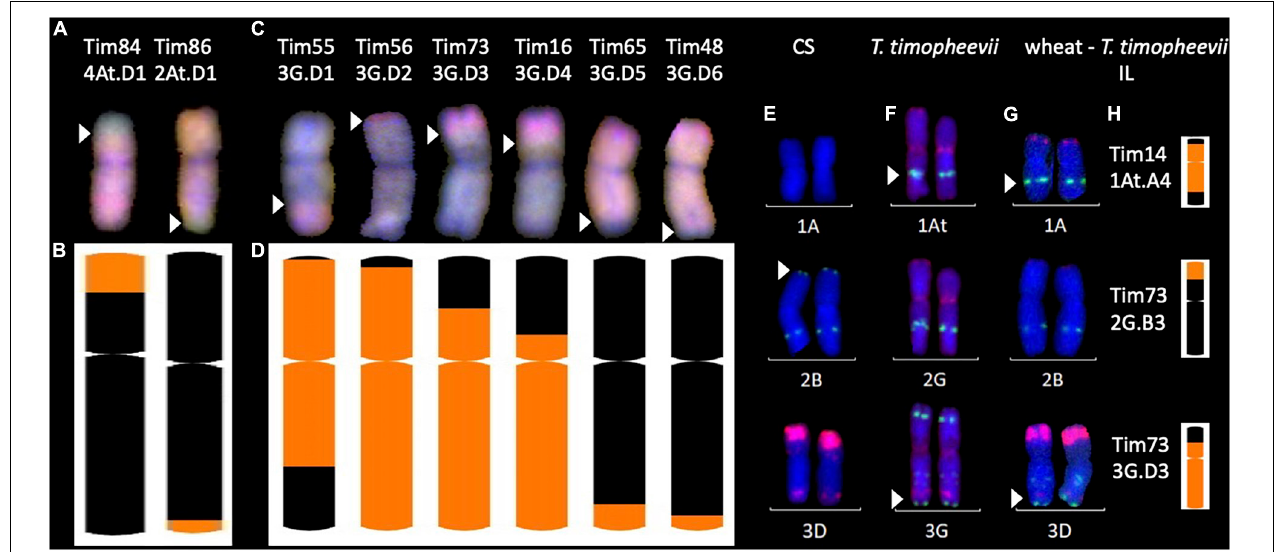
FIGURE 5 | Multi-colour in situ hybridisation analysis of root metaphase spreads of chromosomes from wheat- Triticum timopheevii introgression lines (ILs). (A,C) Multi-colour genomic in situ hybridisation (mcGISH) of ILs with At.D − G.B introgressions, respectively. Green probe detects the A t subgenome and blue detects the G subgenome of T. timopheevii . Red detects the D genome of wheat. (E–G) Multi-colour fluorescence in situ hybridisation (mcFISH) of (E) wheat cv. Chinese Spring (CS), (F) T. timopheevii and (G) ILs where the green and red signals show pSc119.2 and pAs.1 binding sites, respectively. Images for panels (E,F) were taken from Devi et al. (2019). Panels (B,D,H) a graphical representation of the introgressions present in these lines obtained through chromosome-specific KASP marker analysis depicting ideograms of the corresponding ILs shown either above with mcGISH (A,C) or on the left with mcFISH (E–G) . Size of introgressions from A t and G subgenomes is indicated in orange in a wheat chromosome shown in black. White arrows indicate the corresponding recombination breakpoints in the mcGISH and mcFISH